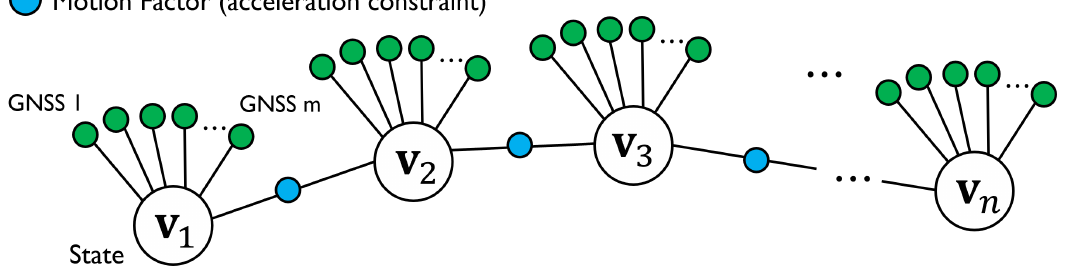
Figure 6. Graph structure of proposed method in velocity-estimation step. The Doppler and motion factors are adopted to estimate the